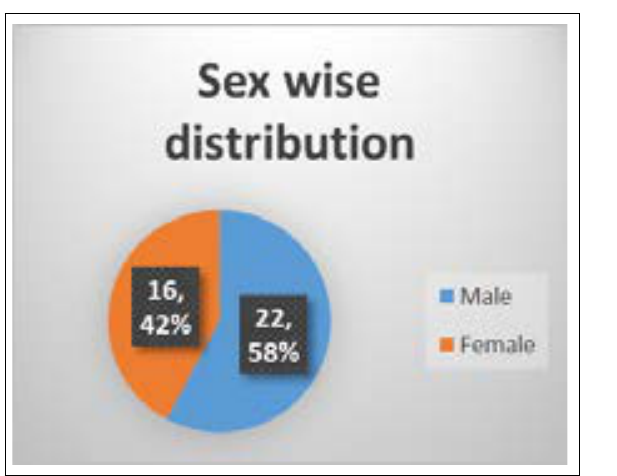
Figure 1. Sex wise distribution.